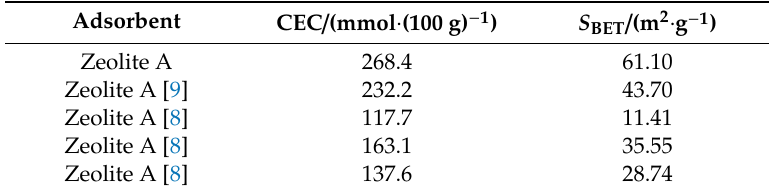
Table 2. CEC and specific surface area of synthesized products in di ff erent works in the